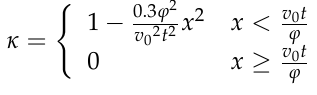
Figure 3. ( a ) shows the variation of fluid pressure along with penetration distance. ( b ) shows the variation of filling degree along with penetration